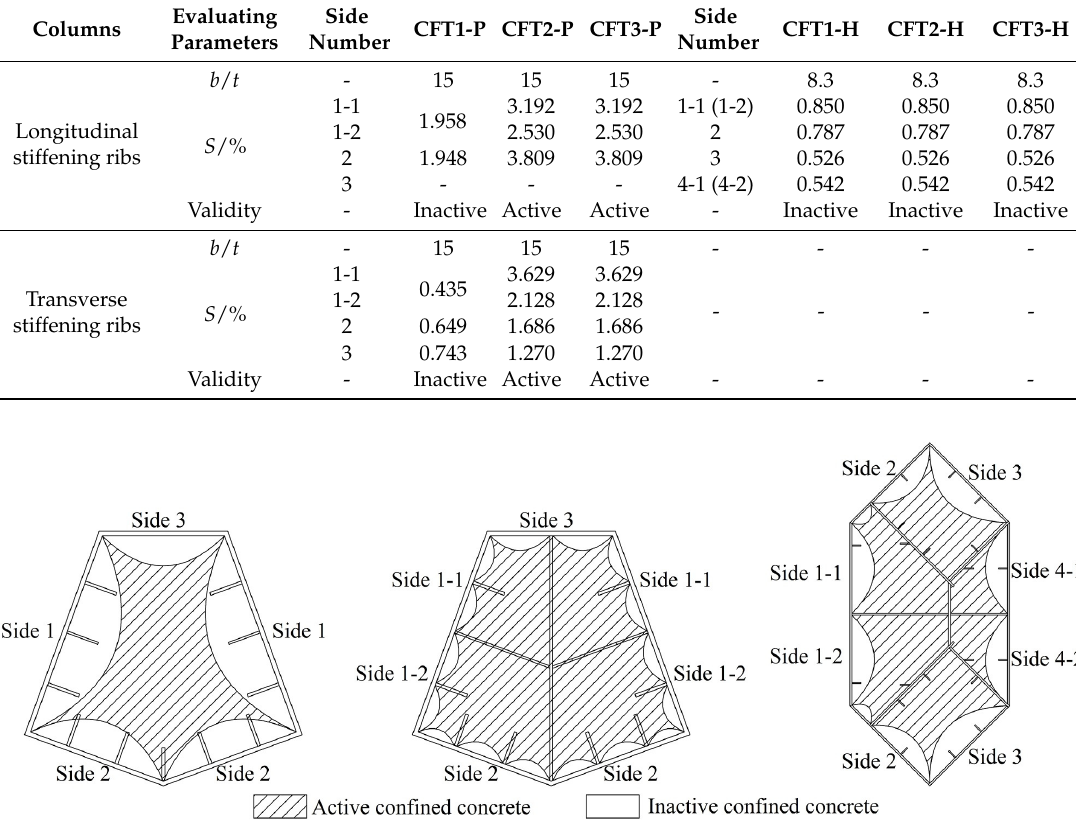
Table 4. The validity determination of stiffening ribs.